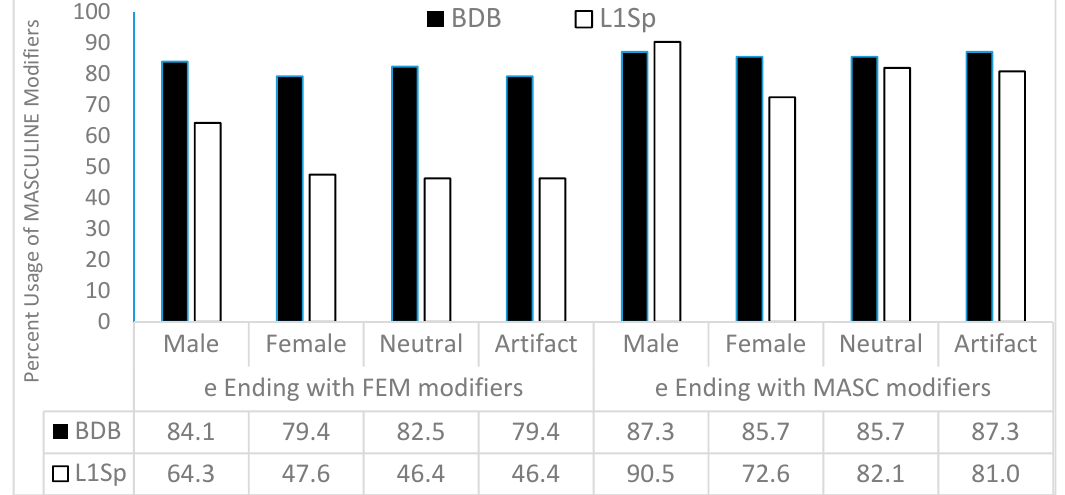
Figure 3. Production of MASC modifiers with - e pseudonouns in reference to male, female, and non-gendered animate objects and artifacts.